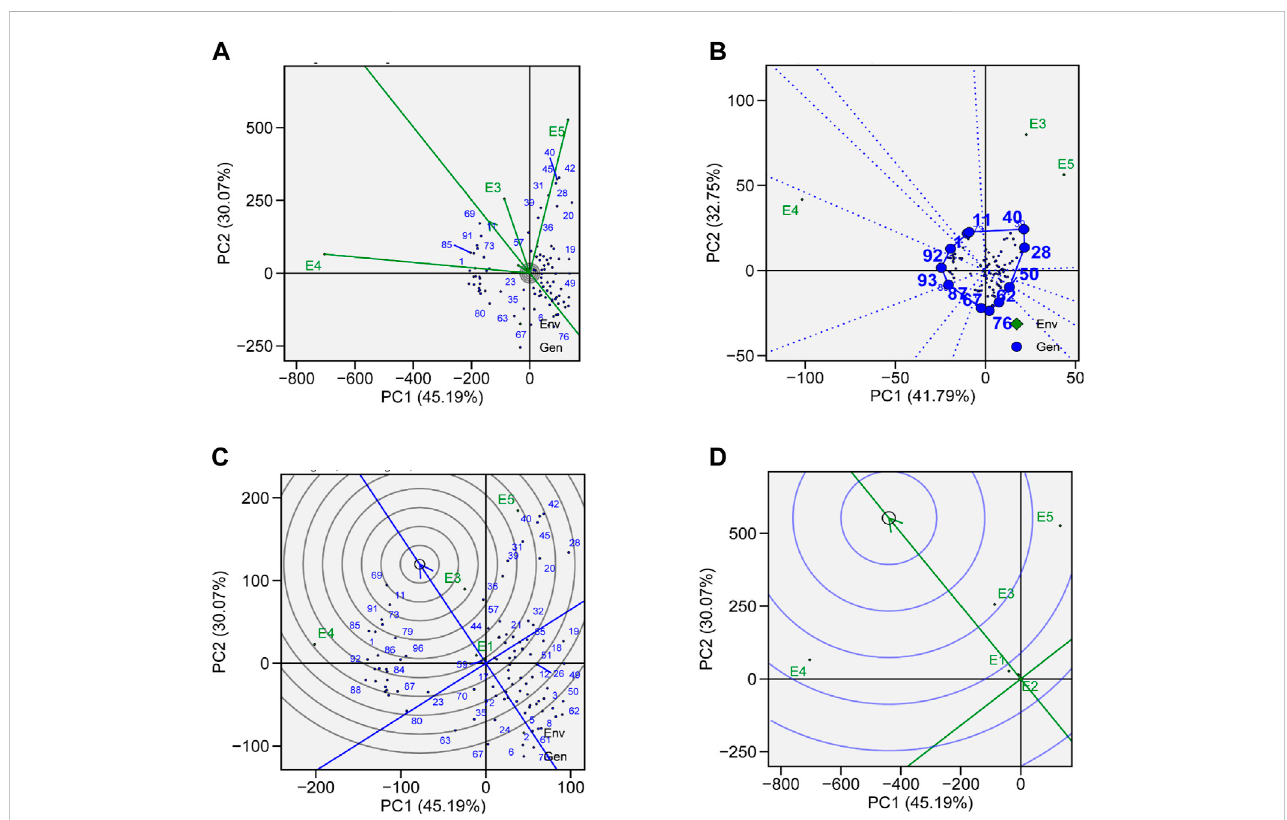
FIGURE 7 (A) Genotype plus genotype × environment interaction (GGE) biplot analysis for representation and discrimination of genotypes. (B) The which – won – where biplot for the yield of 96 soybean genotypes evaluated in fi ve environments. (C) The best genotypes based on average performance and stability are displayed in a yield-focused comparative biplot. (D) Environment-focused comparison biplot explains the ideal environment for soybean yield among the locations used in evaluations.